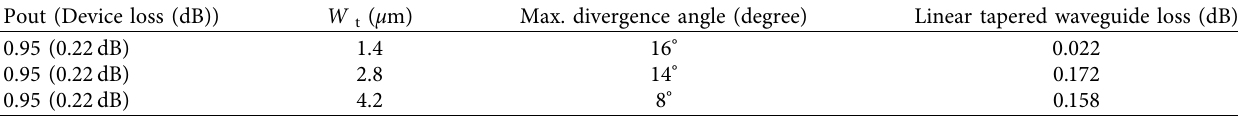
Table 2: A 1 × 1 MMI combined with a linear tapered waveguide device